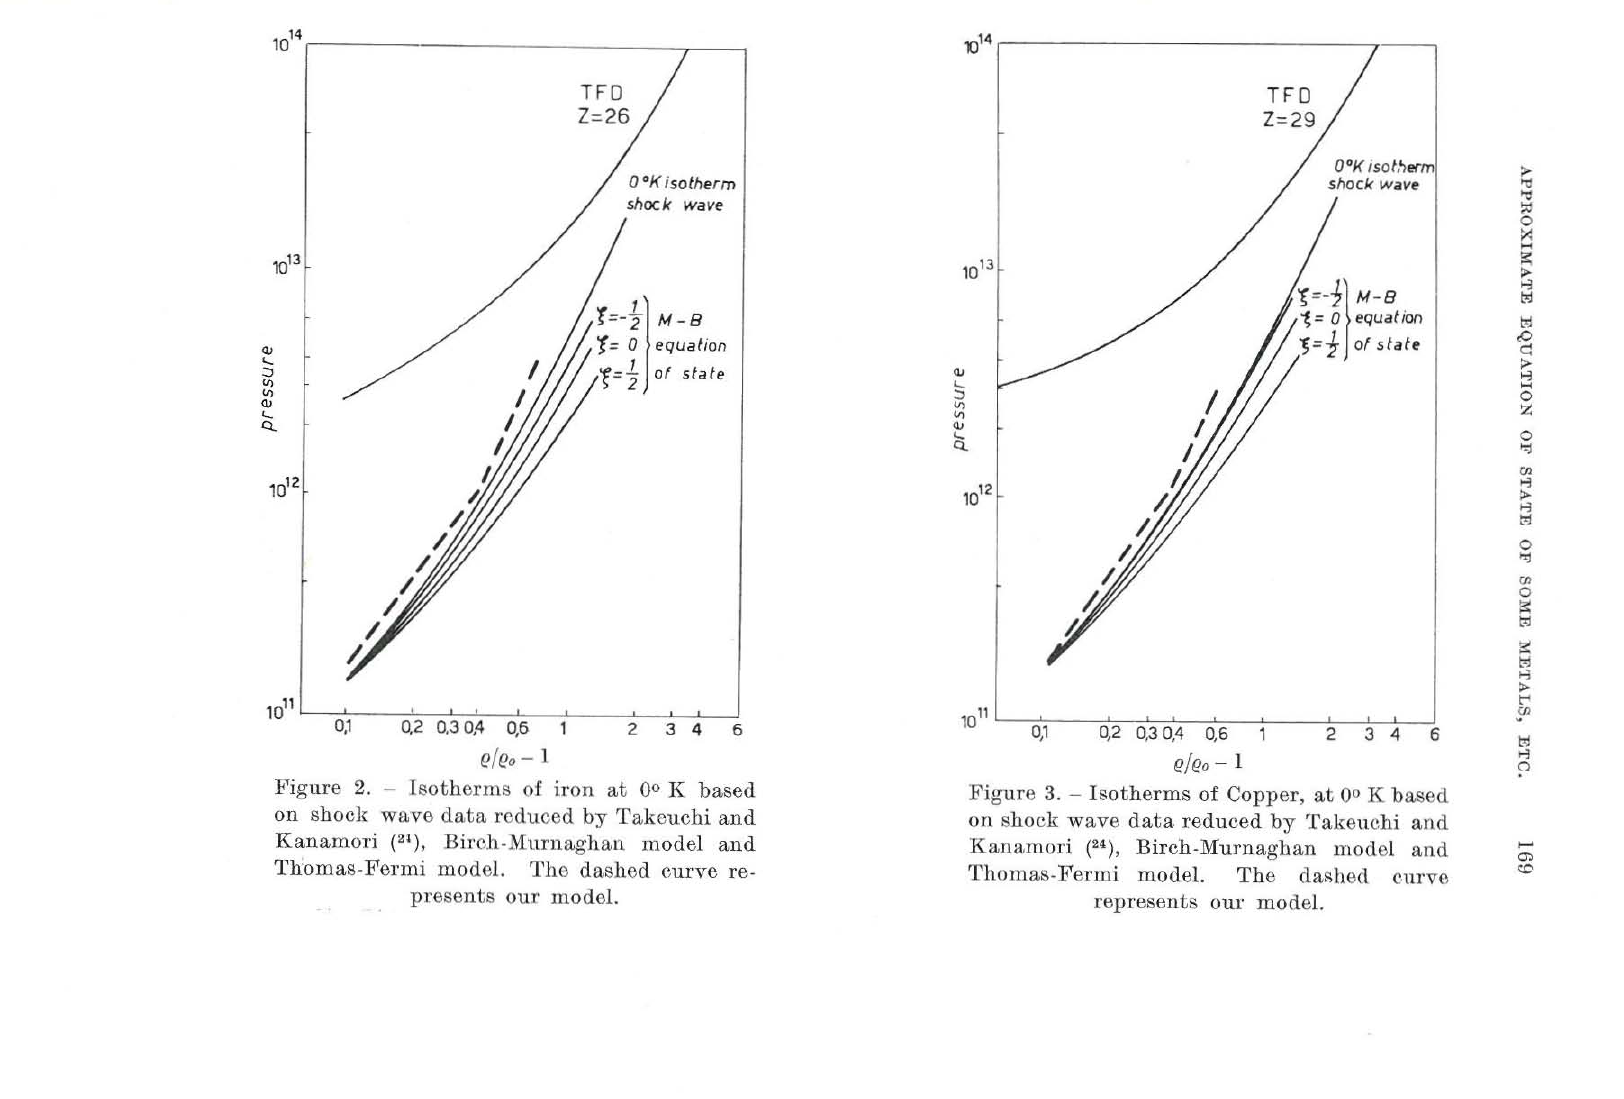
Figure 3. - Isotherms of Copper, at 00 K bascd on shock wave data reduced by Takenchi and Kanamori (2'4.), Birch-Murnaghan model and Thomas·Fermi modei. Tbe dashed CUl'Ve represents om'